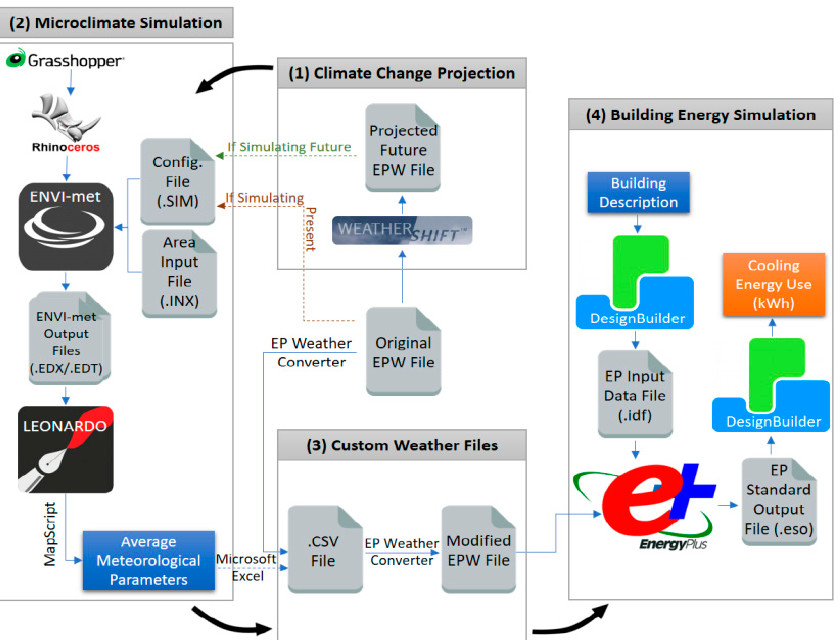
Figure 6. The coupled simulation methodology in present and future as a baseline for ERA Tripling Evaluation Methodology, TEM, modified after [38] .